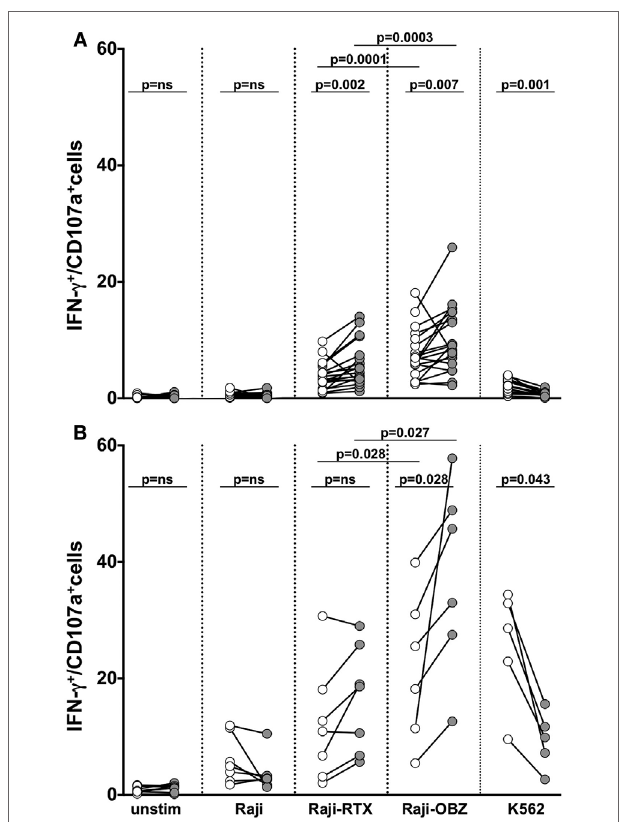
FigUre 5 | Functional responsiveness of fresh and in vitro cultured memory natural killer (NK) cells. Fresh (a) and cultured (B) memory (filled symbols) and conventional (empty symbols) NK cells were stimulated as indicated, and the percentage of CD107a/ + IFN- γ + was evaluated by immunostaining and FACS analysis. p values of pairwise comparisons are from Wilcoxon non-parametric